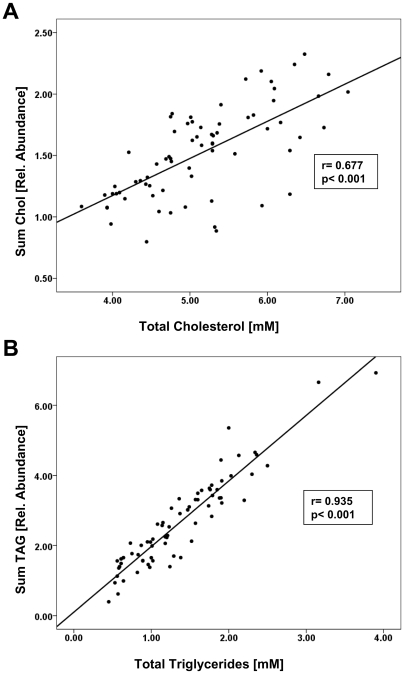
Quantification by top-down lipidomics correlates with clinical indices.A) Linear regression analysis of the total cholesterol content determined by mass spectrometry and by clinical chemistry analysis. Mass spectrometry quantified total cholesterol content by summing up the abundances of free cholesterol, all cholesteryl esters and their common fragment ion at m/z 369.35. B) Linear regression of the total triglyceride content determined by mass spectrometry and by clinical chemistry analysis. Mass spectrometry quantified the total TAG content by summing up all the abundances of individual TAG species. In both panels each dot represents the total extract of individual plasma sample.